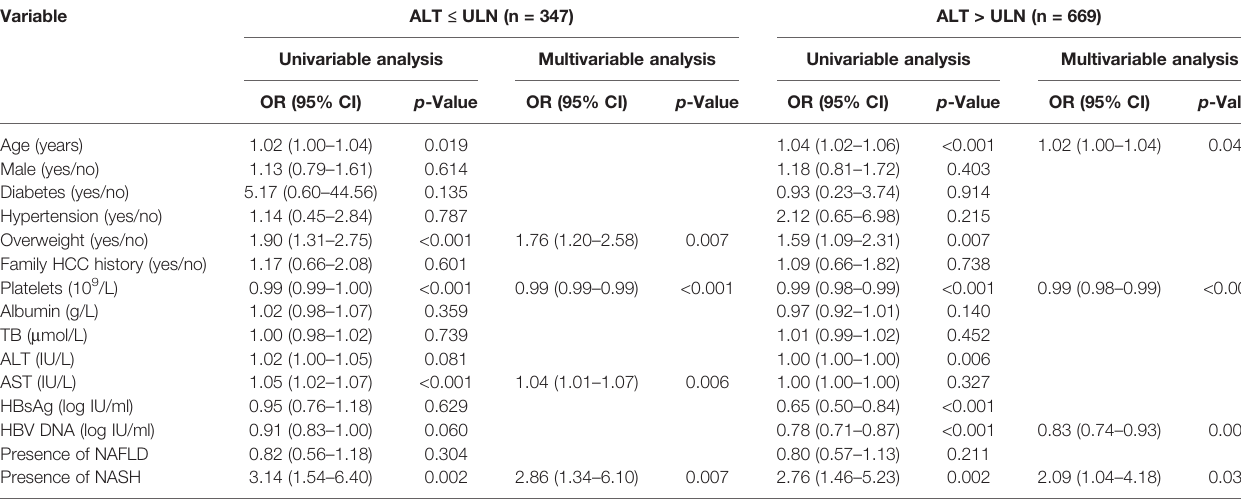
TABLE 6 | Univariable analyses and multivariable analyses of factors associated with signi fi cant fi brosis among patients with normal ALT or abnormal ALT.